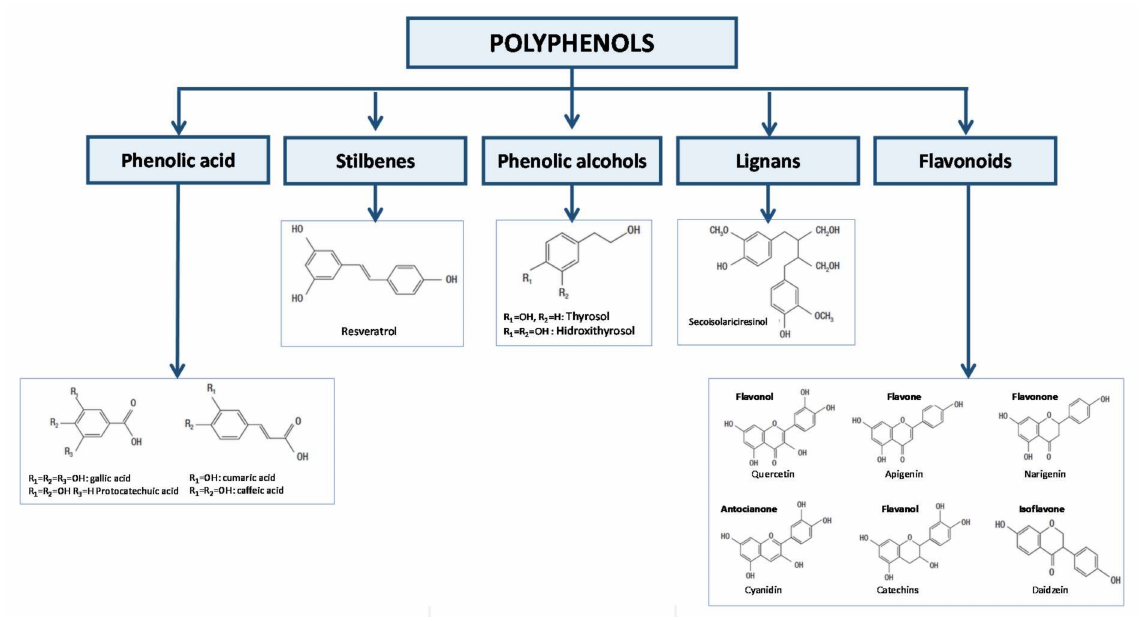
Figure 1. Classification of